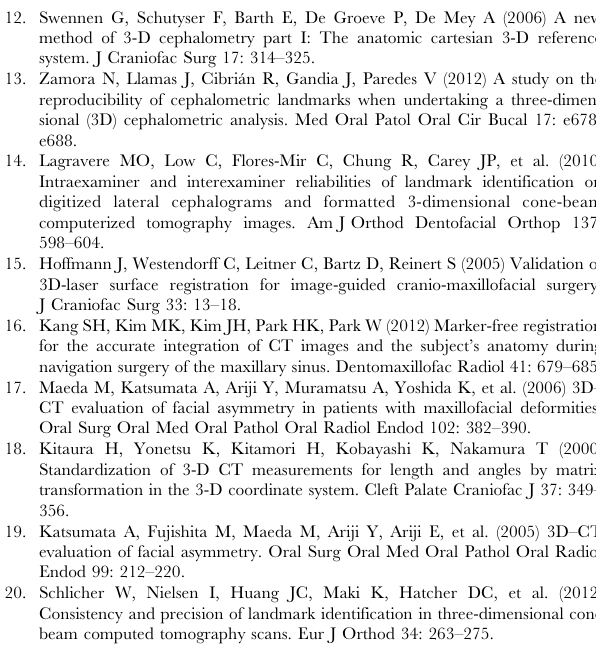
Table S11 Coordinates before and after reorientation (Sample Number 11). Table S12 Coordinates before and after reorientation (Sample Number 12). Table S13 Coordinates before and after reorientation (Sample Number 13). Table S14 Coordinates before and after reorientation (Sample Number 14). Table S15 Coordinates before and after reorientation (Sample Number 15). Table S16 Coordinates before and after reorientation (Sample Number 16). Table S17 Coordinates before and after reorientation (Sample Number 17).